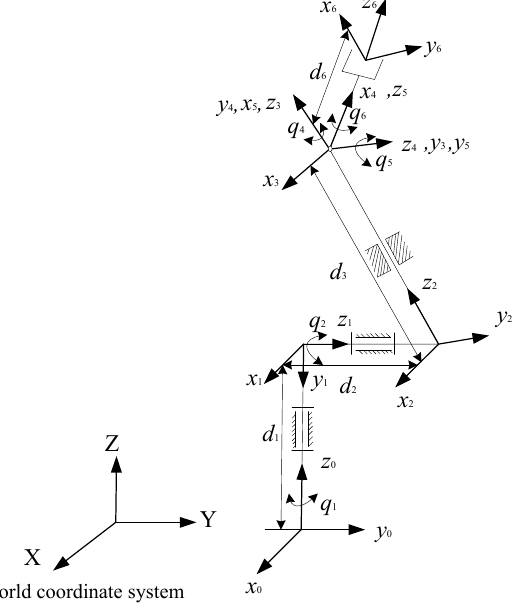
Figure 1. The coordinate system of the Stanford manipulator.